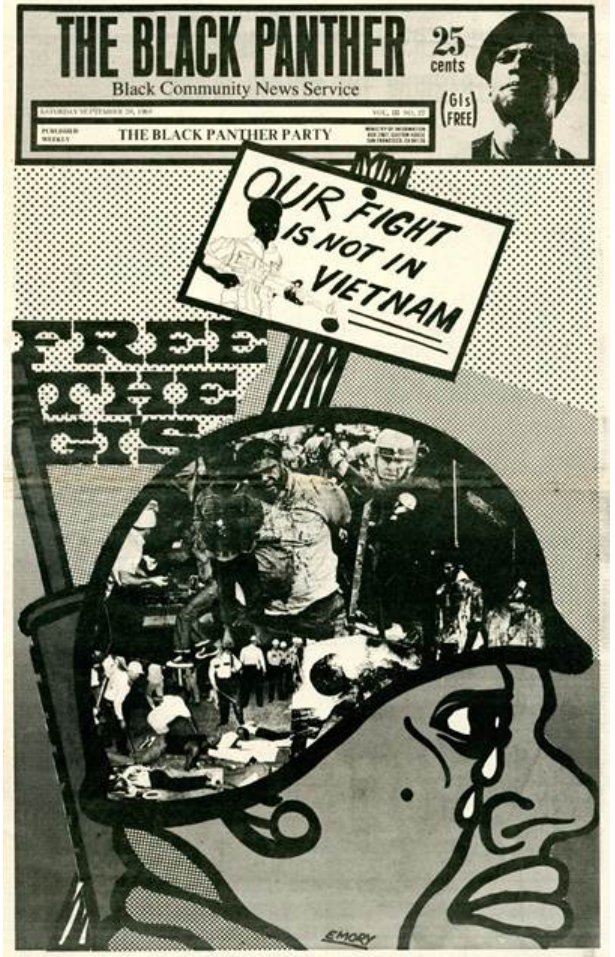
Cover of the Black Panther , 20 September 1969. c (cid:13) Emory Douglas/DACS 2017.